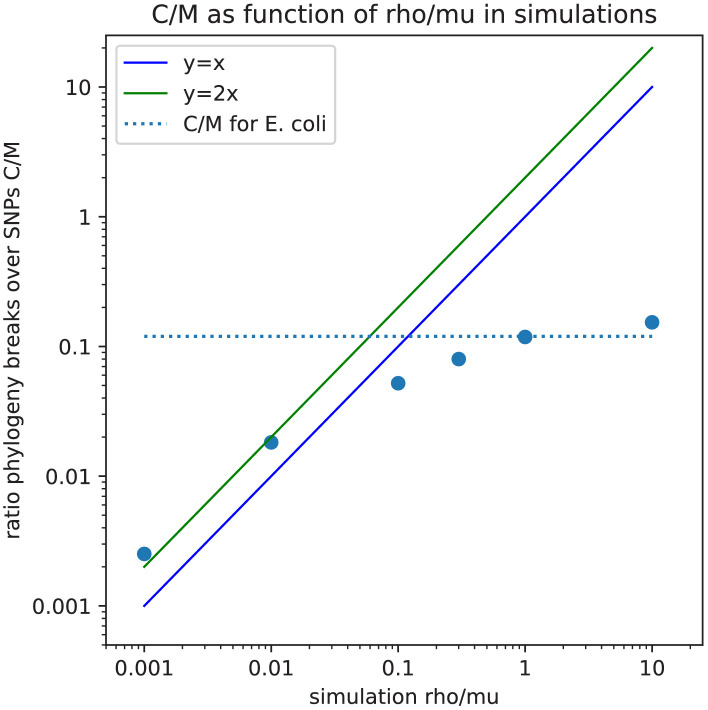
Lower bound C/M on the ratio of phylogeny changes to mutations, versus the ratio ρ/μ of recombination to mutation rate, for the data of the simulations.Observed ratio C/M of the minimal number of phylogeny changes C and SNPs M in the alignment (vertical axis) as a function of the ratio of recombination and mutation rate ρ/μ used in the simulation (horizontal axis), as calculated on the simulation data using the alignments from which 5% of potentially homoplasic sites have been removed. Each blue dot corresponds to a simulation with a given value of ρ/μ. Both axes are shown on logarithmic scales. For guidance, the lines y=x (blue) and y=2⁢x (green) are shown. The horizontal dashed line shows the ratio C/M=0.13 that is observed for the 5% homoplasy corrected alignment of the E. coli strains.